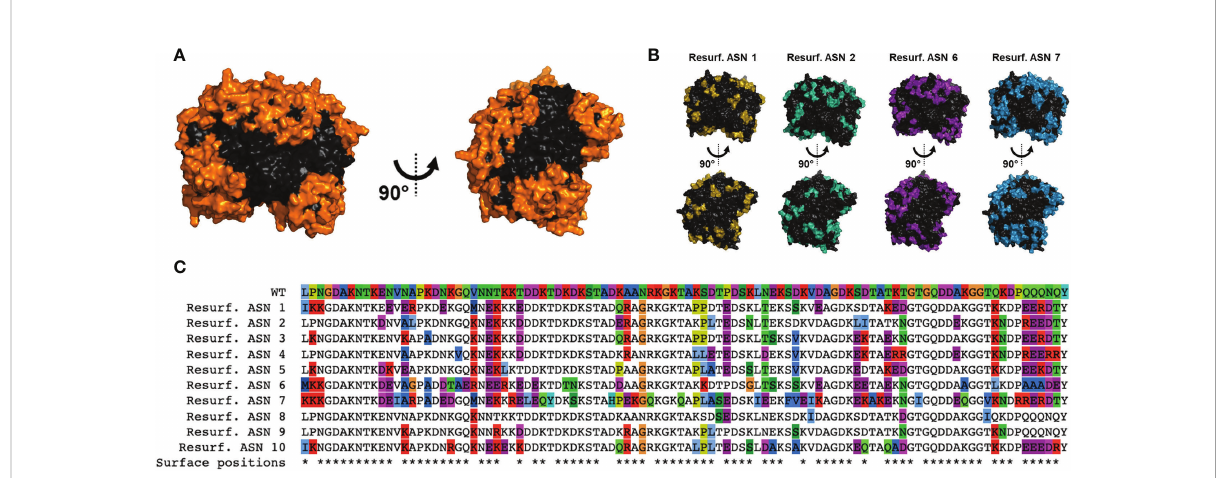
FIGURE 1 Computational design of Re-surfaced ASN variants. Variant proteins were designed referencing wild-type E coli asparaginase (WT ASN) (PDB ID: 3ECA) with mutations focused around residues with a relative solvent accessibility >50% (referred to as surface exposed residues). (A) Structural view of the WT ASN homotetramer with amino acid positions open to mutation shown in orange. (B) Four representative Resurf. variants with colored positions indicating residues with mutations differing from WT ASN. (C) Multiple sequence alignment of the Resurf. ASN designs showing surface exposed and mutated positions. The top row shows the WT ASN sequence with all positions colored by amino acid characteristic (polar in green, nonpolar in blue, positively charged in red, negatively charged in purple, aromatic in cyan, and proline, cysteine, and glycine in unique colors). The bottom row indicates positions classi fi ed as solvent exposed and are denoted with an